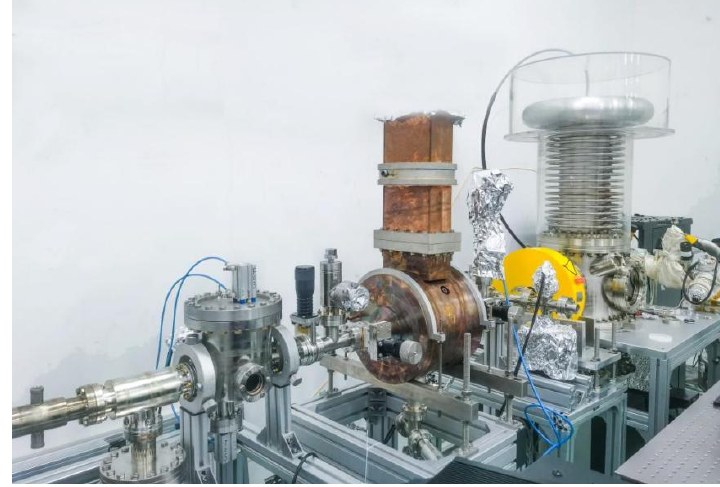
Figure 11. Measurement beamline